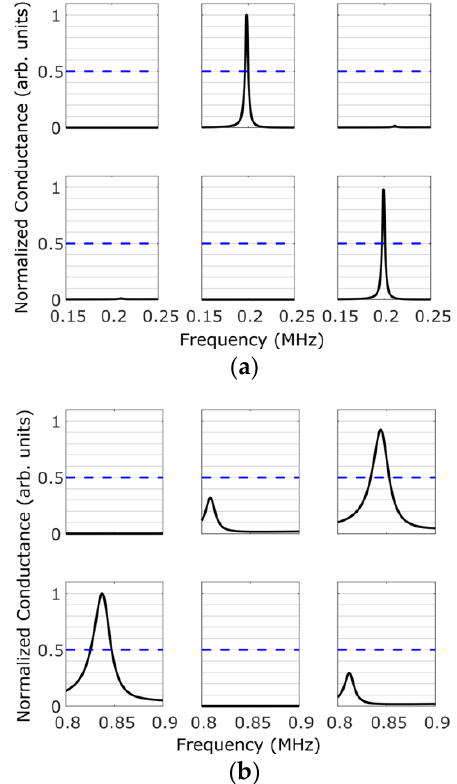
Figure 5. Magnitude of the conductance spectra measured using a multiplexer and a vector network analyzer. The tolerance level chosen for this proof-of-concept is indicated by a blue-dashed line. ( a ) The spectrum corresponding to the window of the first radial mode and ( b ) the spectrum corresponding to the window of third radial mode.